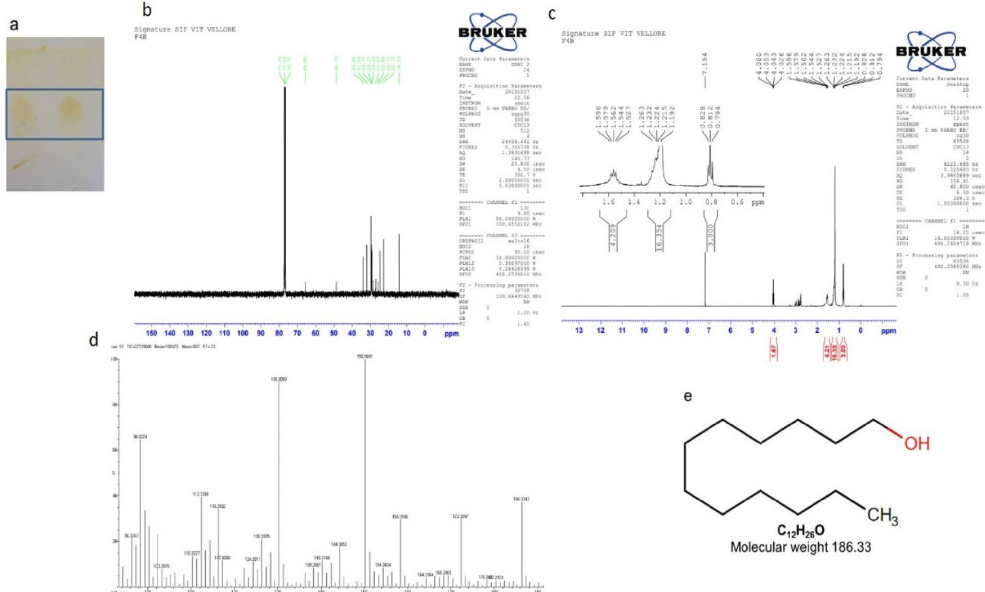
Figure 8. Isolation of compound 3 (1-dodecanol). ( a ) TLC showing a single spot of compound eluted at petroleum ether:ethyl acetate (7:3), ( b ) 13 C NMR, ( c ) 1 H NMR, ( d ) HRMS, ( e ) molecular weight and structure.